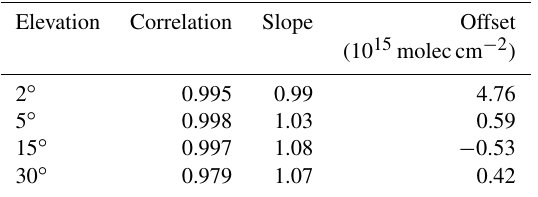
Table 3. Statistics (correlation coefficient, slope and offset) between IMPACT and MAX-DOAS NO 2 slant columns from Fig. 7.